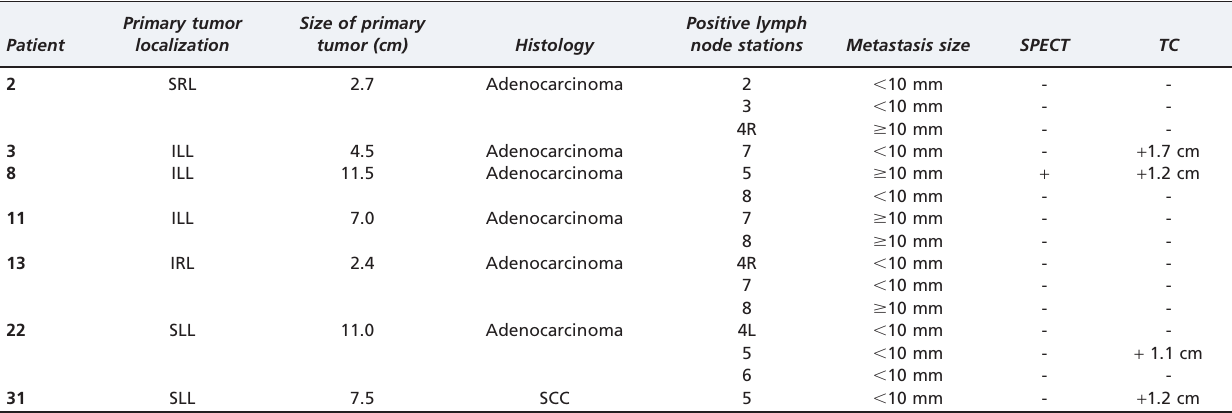
Table 3 - Patients with mediastinal lymph node metastasis (n= 7).